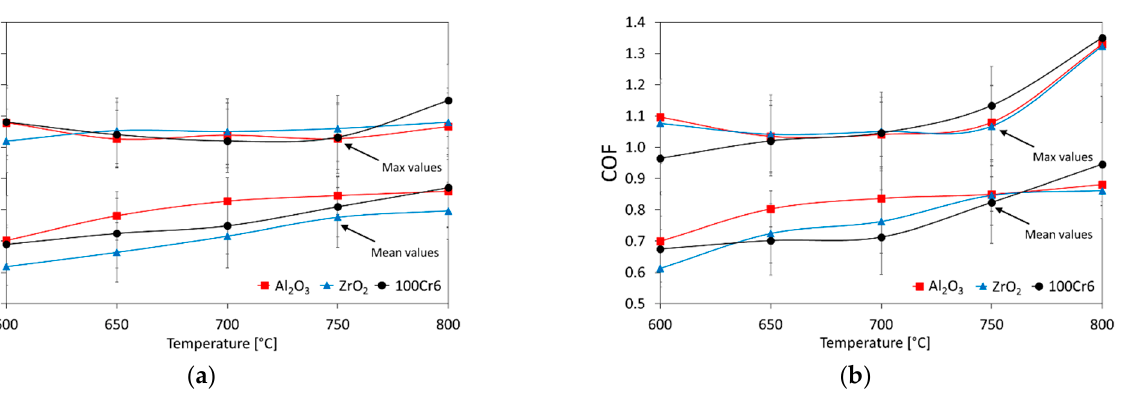
Figure 7. Average and maximum coefficients of friction values after tribological tests of the as-received Ti-6Al-7Nb alloy with Al 2 O 3 , ZrO 2, and 100Cr6 balls.